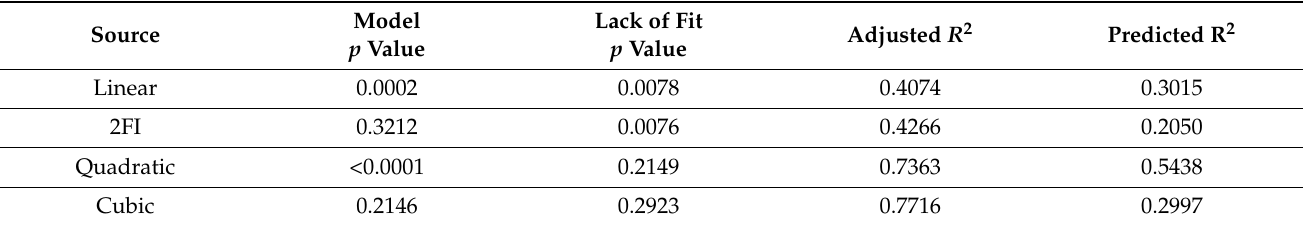
Table 4. Simulation using four models in Design Expert of adhesion force (pull-off) between the applied coating and the substrate